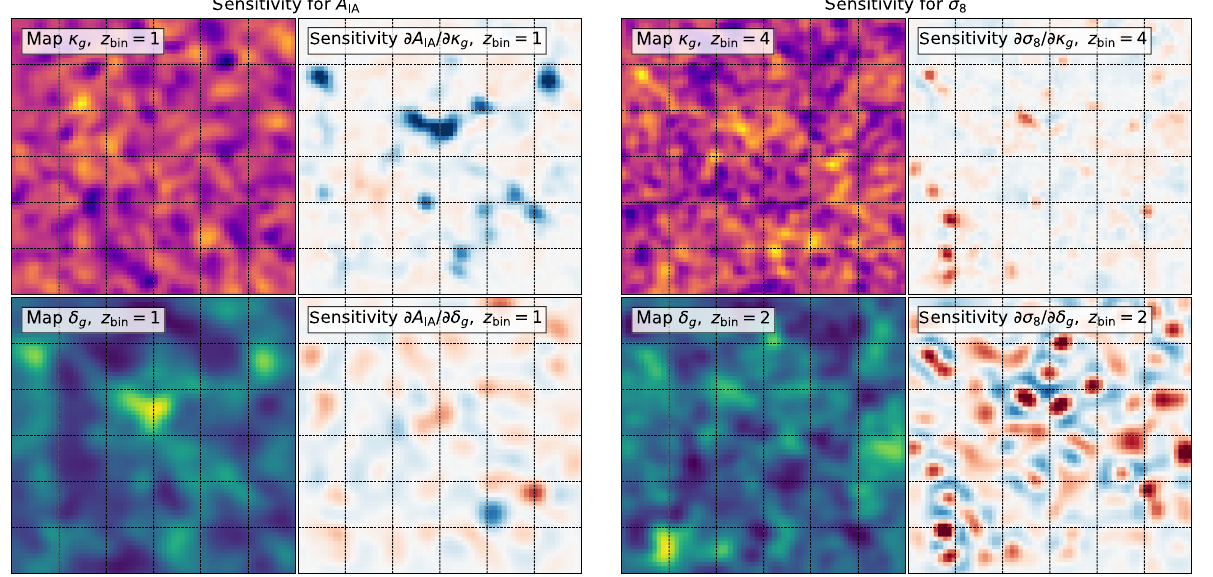
FIG. 6. Sensitivity analysis for the A (left-hand panels) and σ 8 (right-hand panels). We show the κ IA corresponding sensitivity maps on the right. To suppress the noise, the lensing maps are additionally smoothed using a Gaussian kernel with σ ¼ 1 pixel. Regions with higher absolute sensitivity contribute more to the decision of the network about the predicted value of A and σ 8 . Note the correspondence between the galaxy overdensity map and the lensing sensitivity map for bin 1; the areas of large IA overdensities are weighted higher in the κ m